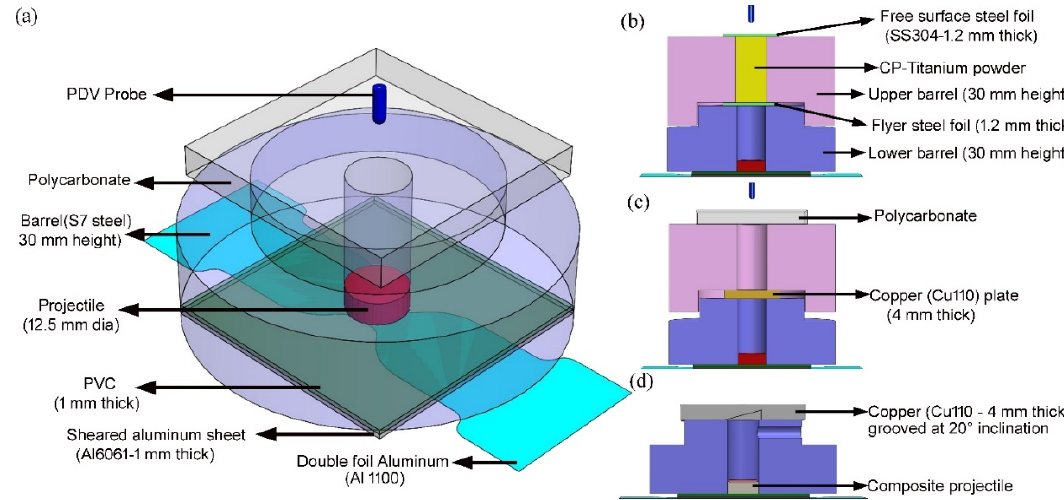
Figure 2. A schematic showing: ( a ) the experimental setup for the measurement of projectile velocity using the Photonic Doppler Velocimetry (PDV) probe, ( b ) powder compaction of commercial pure titanium (CP-Ti), ( c ) spalling of copper (Cu110) plate, and ( d ) 20° inclined collision welding between copper (Cu110) and steel (AISI 1018).